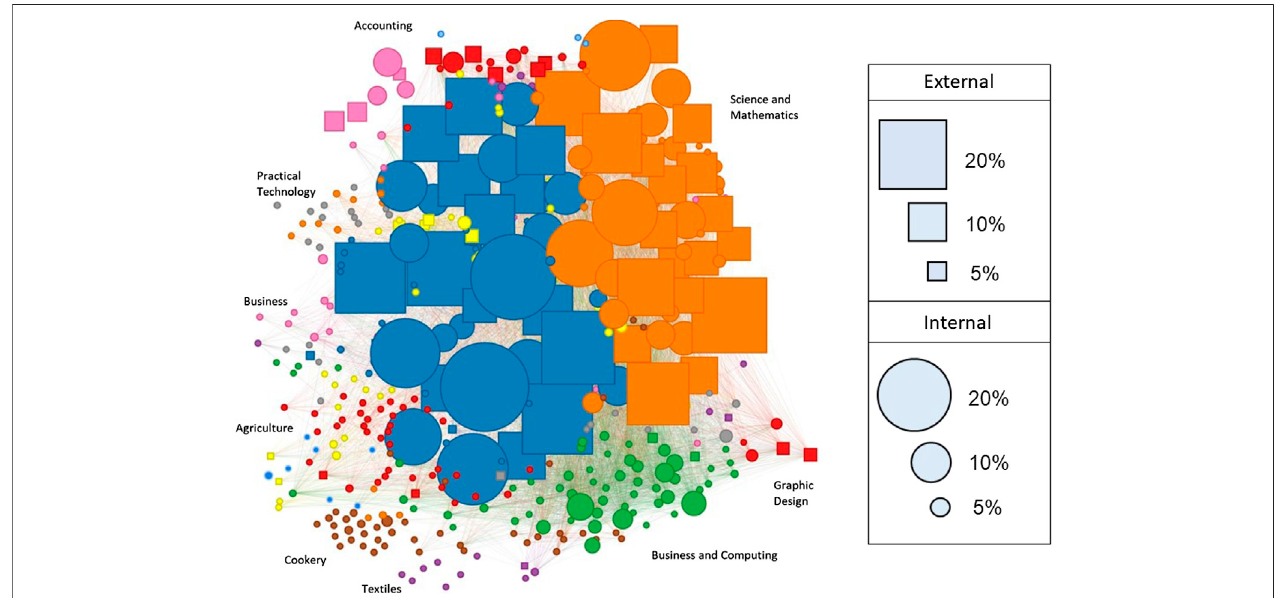
FIGURE 5 | Network of NCEA Level 3 Standards. The overall standard projection of the NCEA Level 3 standard co-enrolment network. The above network is a composite of all standards offered between 2010 and 2016, and serves to provide an overall guide to the various subject disciplines represented by each community. Nodes represent standards and edges represent a preference for two standards being enrolled in at the same time by students. Colors represent the communities of standards that tend to be taken together. Squared nodes represent externally assessed standards, and circular nodes represent internally assessed standards. Node size re fl ects the percentage of all students enrolled in a